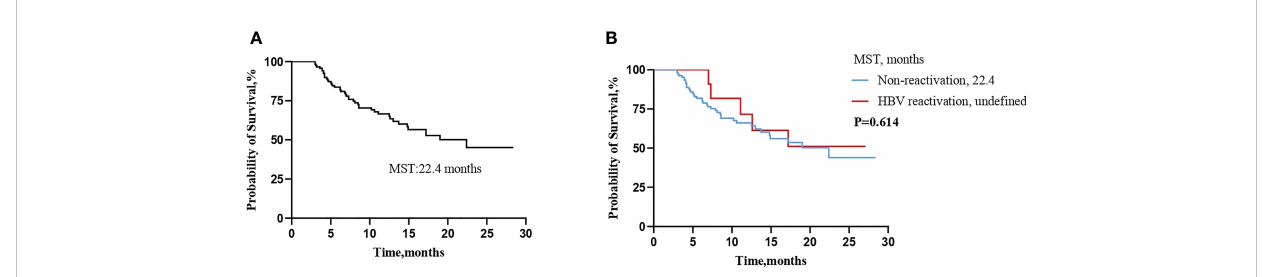
FIGURE 2 Kaplan-Meier curve for over survival (OS) time (A) in all enrolled patients, (B) in patients with or without HBV reactivation. (MST, median survival